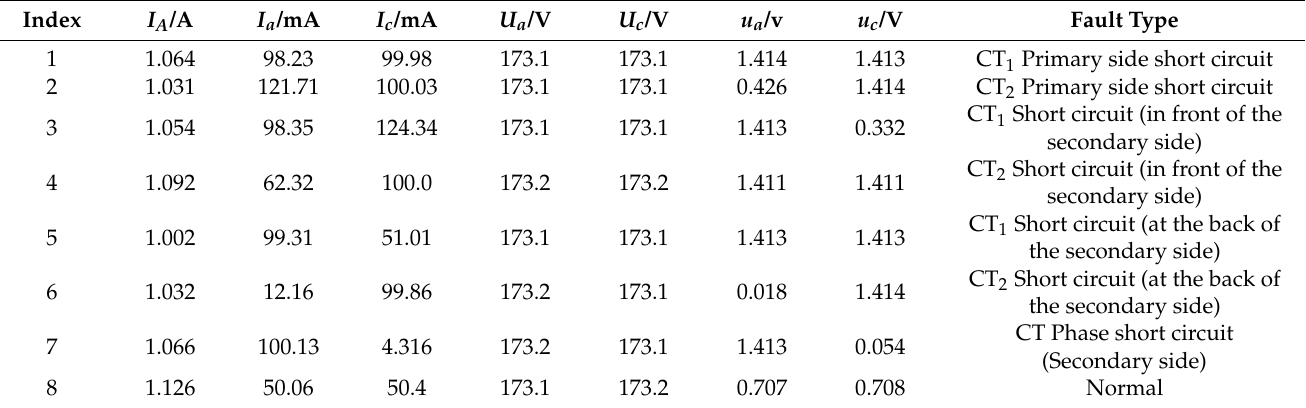
Table 5. Selected sample data from the test platform.